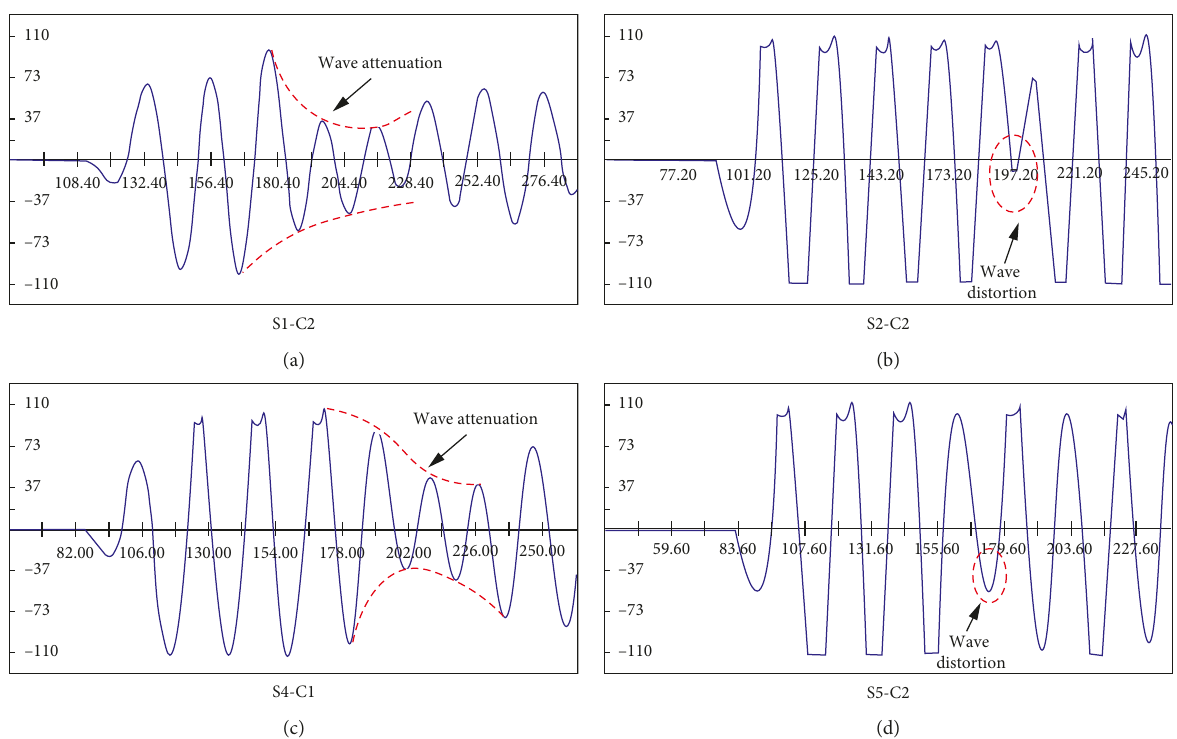
Figure 13: Waveform distortions. “S” is short for sample, and “C” is short for crack width. For example, “S4-C1” indicates result of sample 4 with crack width of 0.1mm.